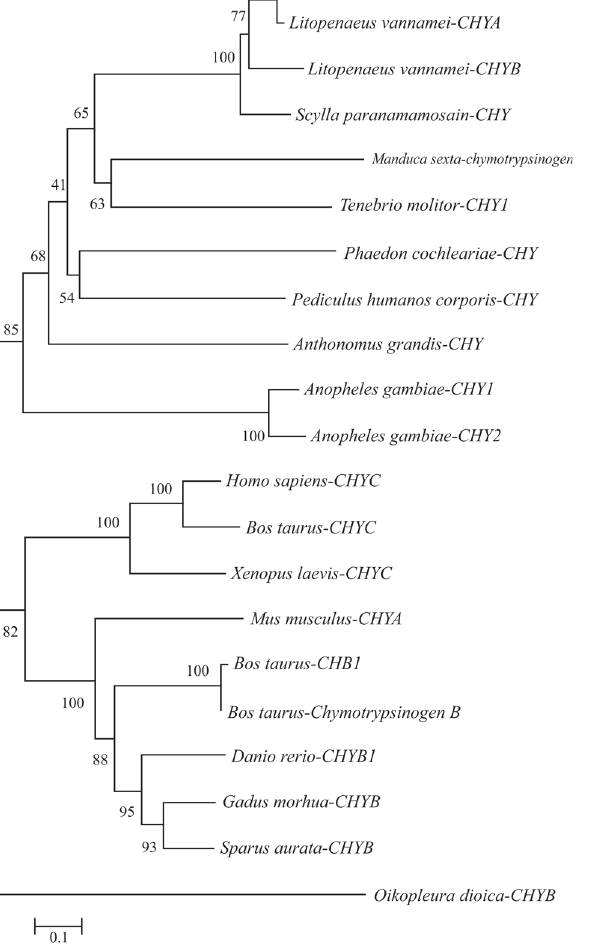
Figure 3 - Phylogenetic analysis of SpCHY with other chymotrypsins. A NJ tree was produced with Mega3.1 software. One thousand bootstraps were carried out to check the repeatability of the result. L. vannamei - CHYA (CAA71672), L. vannamei -CHYB (CAA71673), F. chinensis -